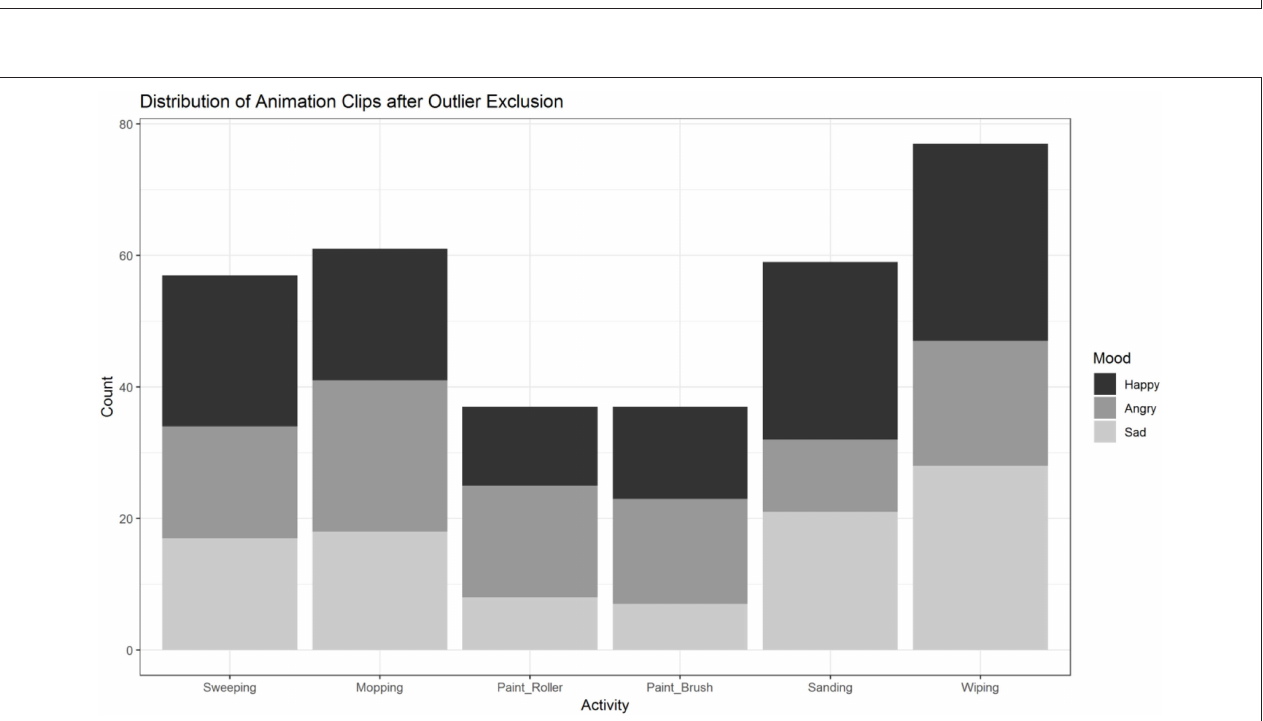
FIGURE 8 | Distribution of motion frequency across moods. Significant differences are found in the mean motion frequency between happy and sad movements, angry and sad movements and notably also between happy and angry movements (in all mentioned contrasts: ps < 0.001 ).